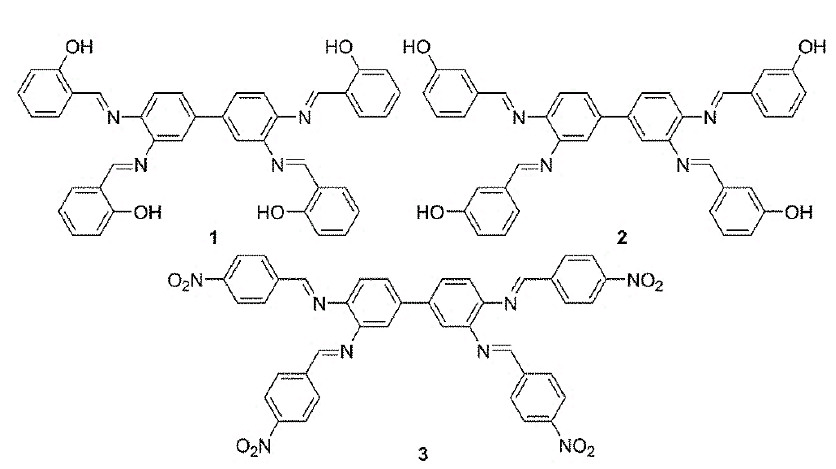
Figure 1. Schiff bases 1 – 3 .